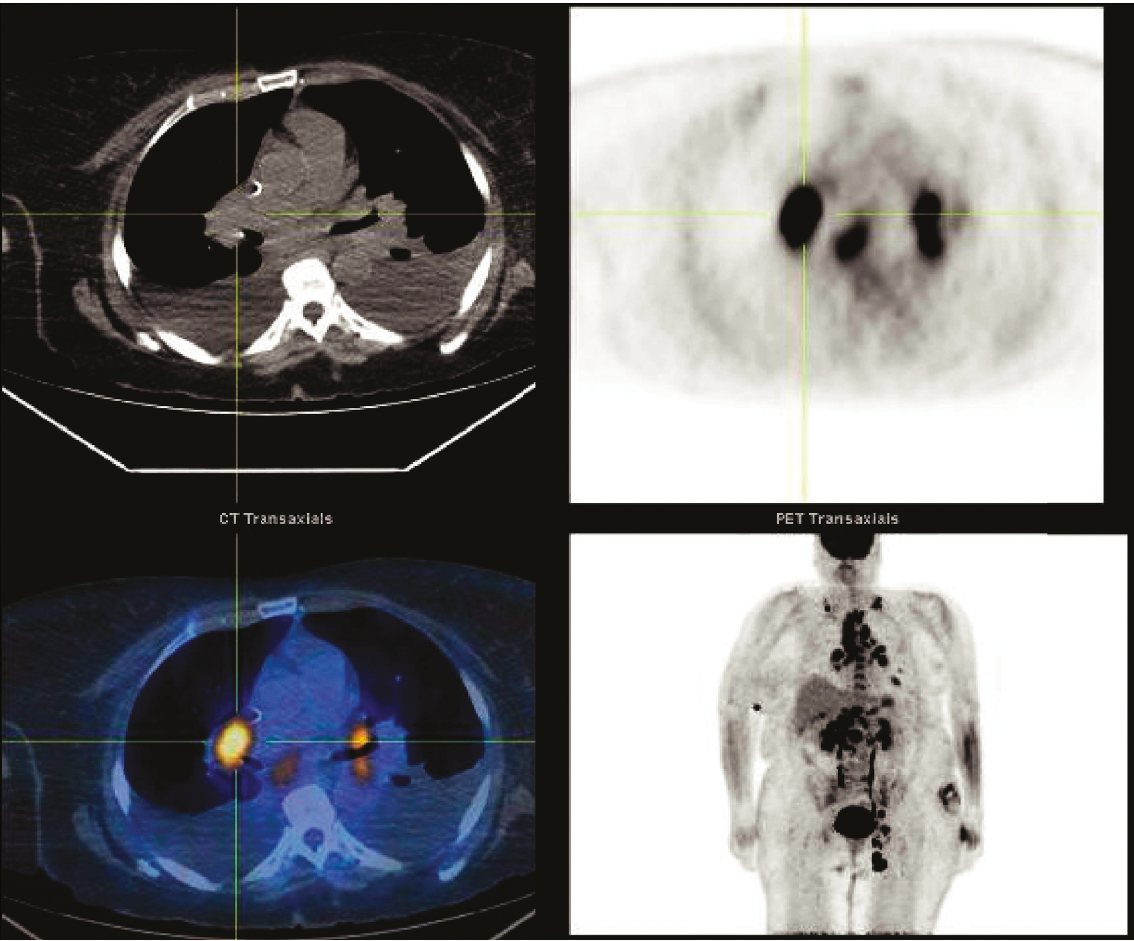
Figure 7: Positron emission tomography (PET) scan assessment of tumor burden before CHOEP chemotherapy initiation. Increased uptake in the bilateral supraclavicular (SUV 10.9), paratracheal (SUV 12.1), hilar (SUV 12.9), periportal (SUV 10.3), left inguinal (SUV 16.9) lymph nodes, pulmonary nodule (SUV 6.1), and right hepatic lobe (SUV 4.7). CHOEP: cyclophosphamide, Adriamycin, vincristine, etoposide, and